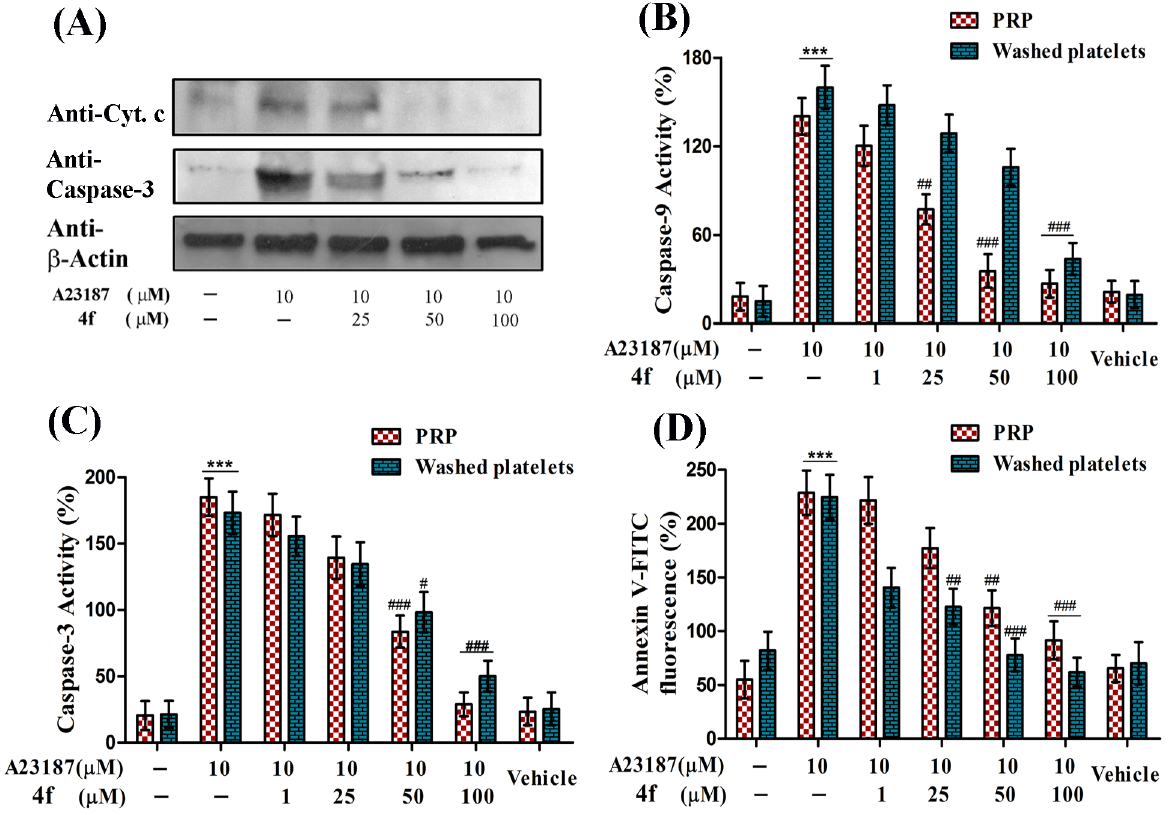
Figure 4. Effect of compound 4f on A23187 induced (A) Translocation of cytosolic cytochrome C and activation of caspase-3 (B) Caspase-9 and (C) Caspase-3 activities and (D) PS externalization in PRP and washed platelets. Values are presented as mean 6 SEM (n=5), expressed as percentage increase in (B & C) caspase activity and (D) Annexin V-FITC fluorescence and expressed as percentage increase in apoptotic platelets expressing PS relative to control. *** p , 0.001; significant compared to control. # p , 0.05, ## p , 0.01, ### p , 0.001; significant compared to A23187.